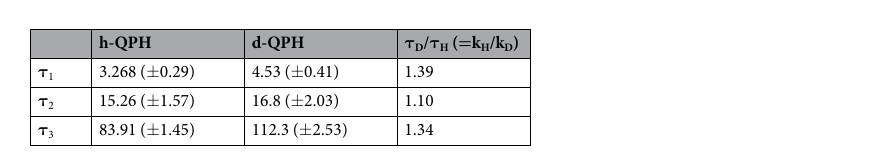
Table 1. Lifetimes (in ps) of h-QPH and d-QPH and their ratios. τ 1 was determined from single exponential fitting of the sub-2 ps profile, while τ 2 and τ 3 were determined from biexponential fitting of over-30 ps profile. ( * Standard error in